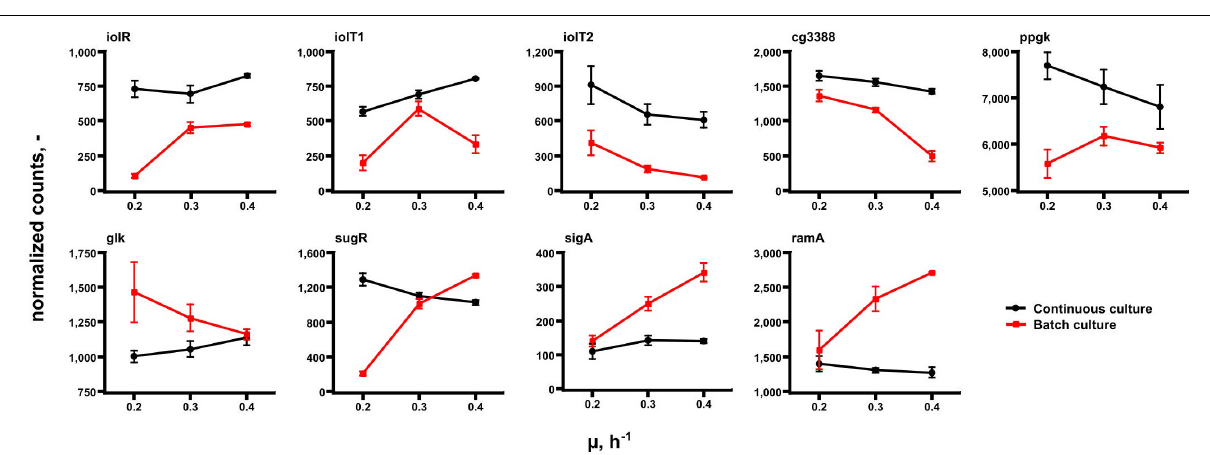
FIGURE 6 | Gene expression levels of a selection of genes coding for glucose uptake and regulation in C. glutamicum. Samples were taken at µ = 0.2, 0.3, and 0.4 h - 1 in continuous (chemostat) runs (black) and in batch mode (red). Data of the latter are taken from Haas et al. (2019) reflecting the acceleration of growth of the same strain in the same medium after preceding glucose